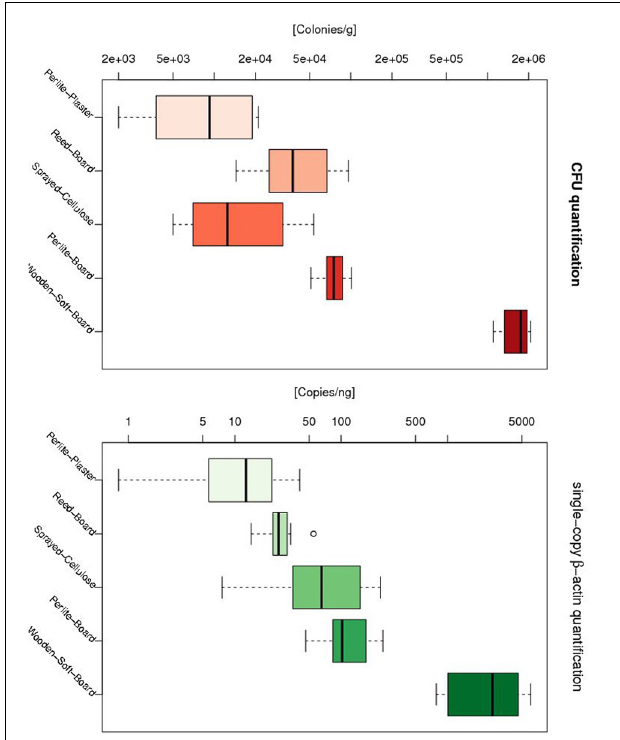
FIGURE 1 | Distribution of fungal abundance for different growth materials as measured by CFU (l.h.s) and qPCR (r.h.s). For both metrics the bloated Perlite plaster and wooden soft-board showed the lowest and highest fungal abundance, respectively. The only inconsistence between CFU and qPCR was seen between the reed board and the sprayed cellulose, where the latter showed a reduced fungal abundance compared to sprayed cellulose based on the qPCR methodology, but a higher fungal abundance based on the CFU approach.